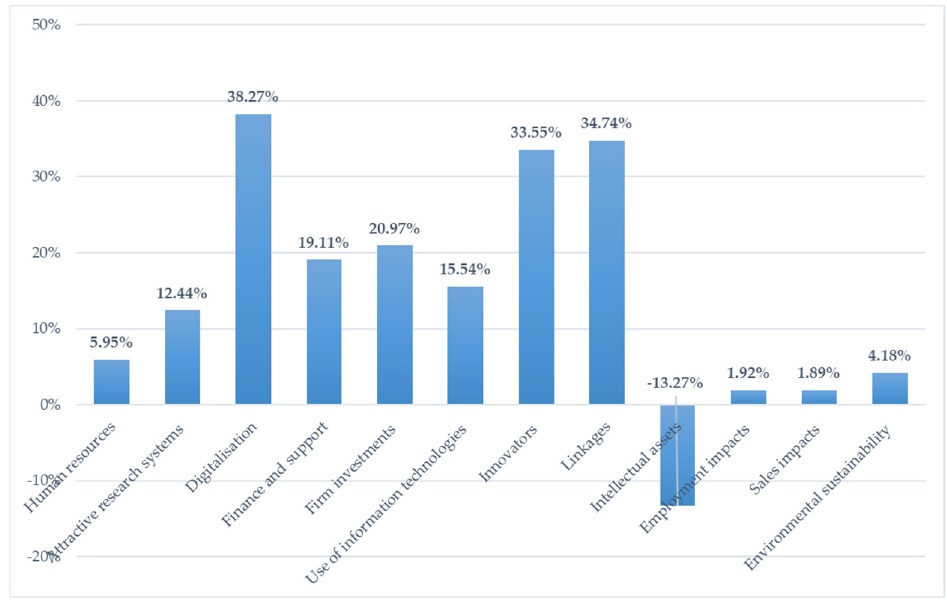
Figure 2. Poland’s gap to EU’s average using particular innovativeness assessment criteria in European Innovation Scoreboard, 2021.